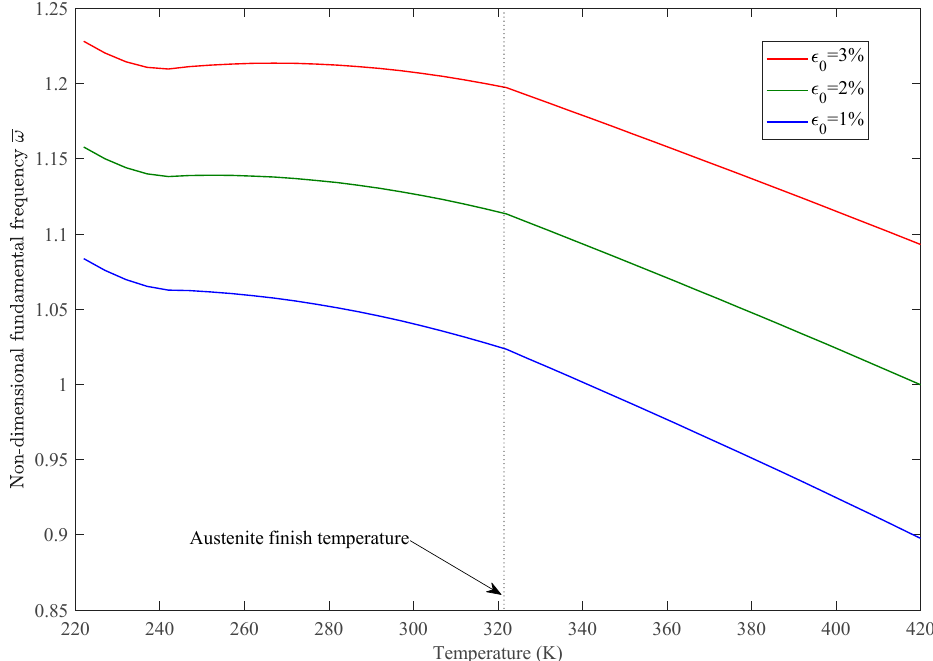
Figure 7. Variation of nondimensional fundamental frequency with temperature for different SMA pre-strains, with [SMAHC/0/0/0]s, Vs = 15%, CCCC boundary condition.